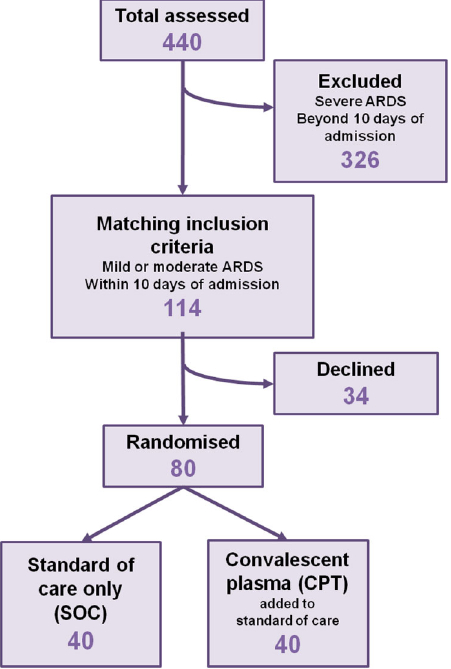
Fig. 2 Clinical trial design and patient recruitment. Diagram representing the design of the randomized control